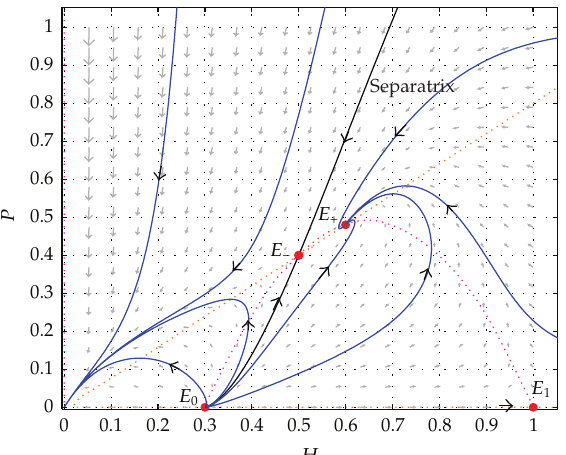
Figure 1: The phase portrait of model (7) with the strong Allee effect. The parameters are taken as 𝑎 = 0.25 , 𝛿 = 0.8 , 𝑚 = 1.3 and 𝑟 = 0.15 . In this case, 𝐸 0 = (0.3, 0) is an unstable node point, = (1,0) and 𝐸 = (0.5, 0.4) are saddle points; the positive 𝐸 1 − equilibrium 𝐸 + = (0.6, 0.48) is local asymptotically stable. There exists a separatrix curve determined by the stable manifold of the equilibrium point 𝐸 − . The dotted curves are the nullclines.